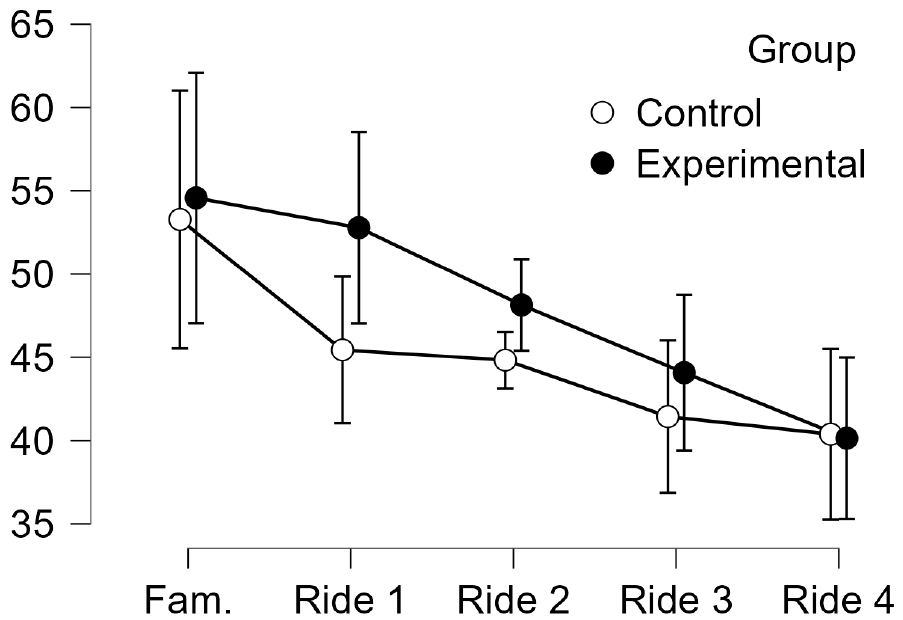
Figure 2. Results of the DALI questionnaire. The error bars represent a 95% confidence